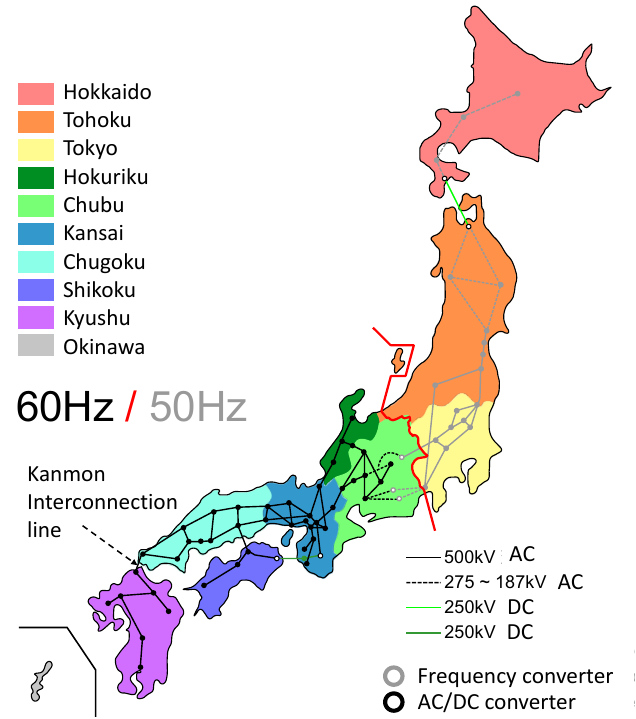
Figure 1. Electricity grid and utilities in Japan (Source: Callum, 2013).